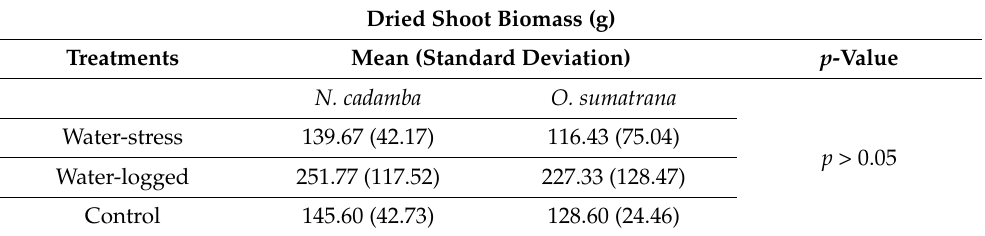
Table 5. Mean values of dried shoot biomass (g) of N. cadamba and O. sumatrana seedlings under different treatments ( n = 3) were not significantly different ( p > 0.05) using two-way ANOVA followed by Tukey’s HSD post hoc.